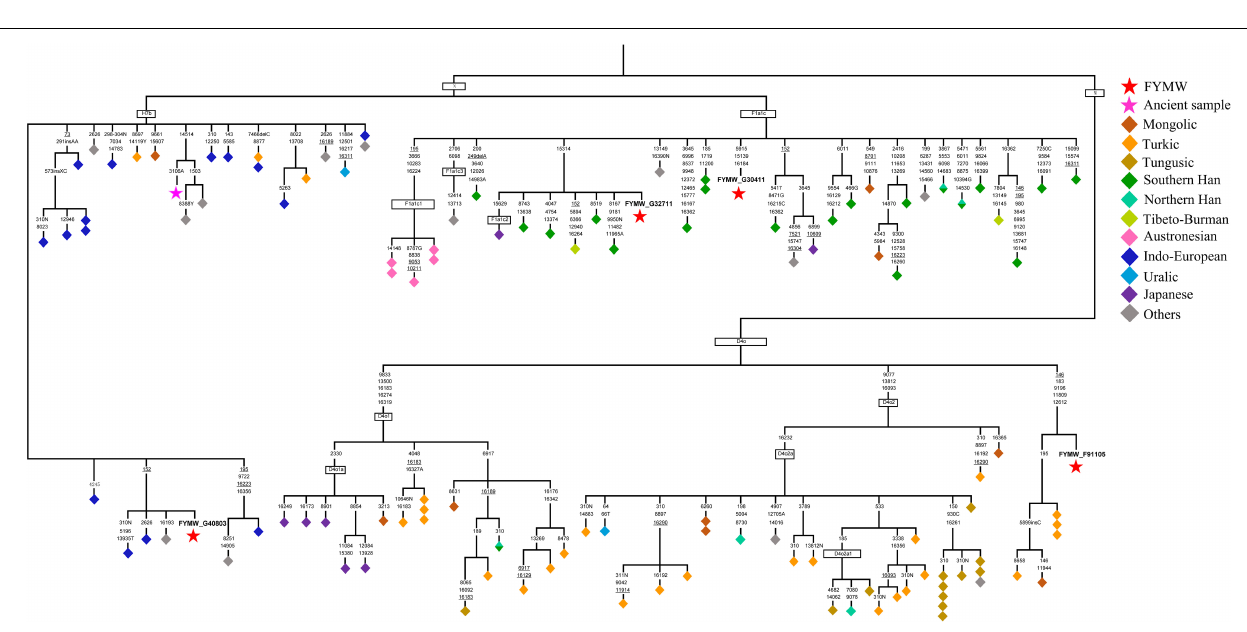
FIGURE 6 | Maximum-parsimony phylogenetic trees of complete mtDNA sequences belonging to haplogroup Haplogroups D4o, F1a1c, and H7b*. Transversions are further specified; ins and del denote insertions and deletions of nucleotides, respectively, back mutations are underlined.